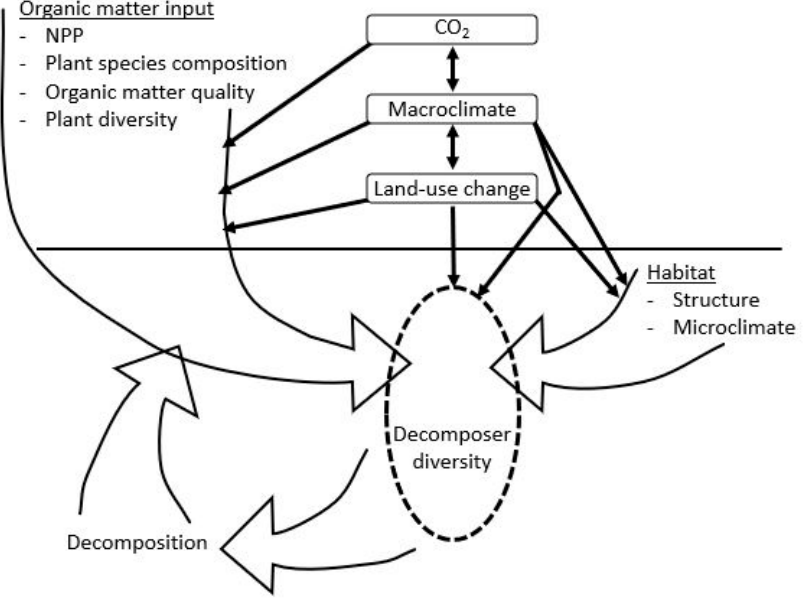
Figure 4. A conceptual view of relationships between global change phenomena, plants, soil decomposers and decomposition. Modified from Wardle et al. [34]. (Permission asked for from Global Change Biology ).